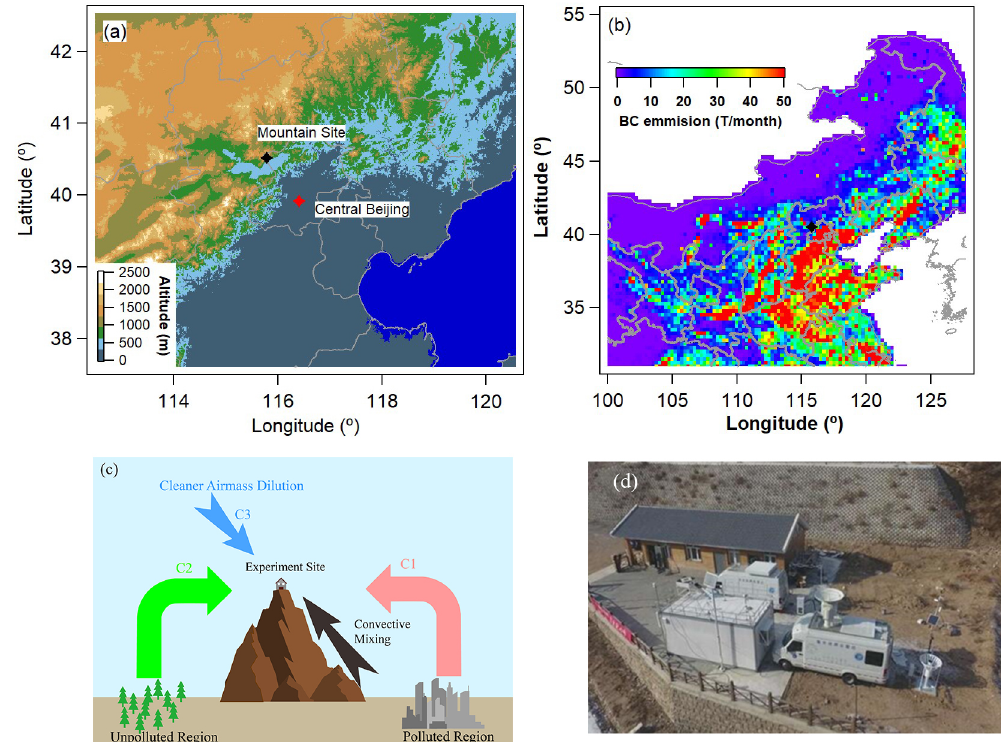
Figure 1. Experimental site descriptions. (a) The location of the experimental site and central Being, marked with black and red stars, respectively, where the colour bar denotes the terrain height and blue denotes the sea. (b) The monthly BC emission inventory in China (Li et al., 2017). (c) Schematic illustration for different types of PBLs defined in this study. (d) Photo of the mountain